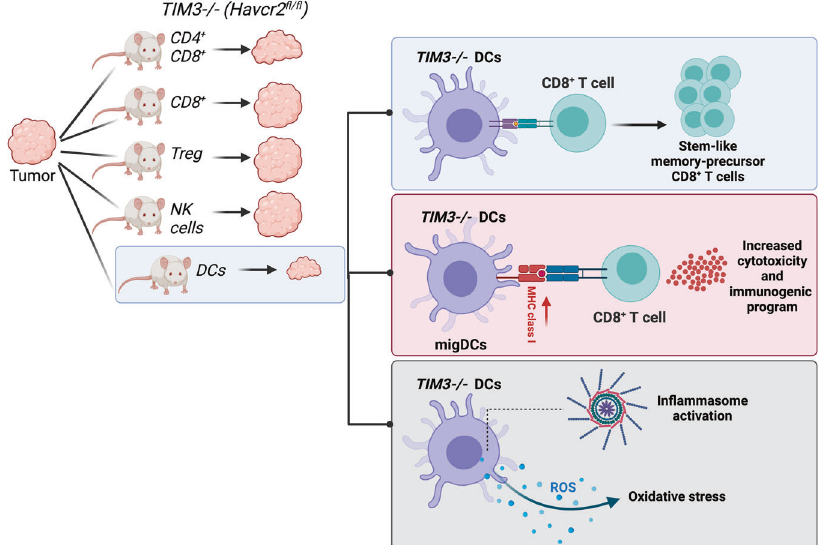
Fig. 1 TIM3 adjusts “ tumor immune temperature ” via dendritic cells (DCs). Among many other immune cells, TIM3 ablation in T-cells shows a mild anti-tumor activity while it reaches the maximum in DCs. TIM-3 ablation increases ROS-induced in fl ammasome activation, especially in migDC subtypes, subsequently enhancing CD8 + T cell cytotoxic activity and stem-like memory precursor formation in immunogenic tumors (created with